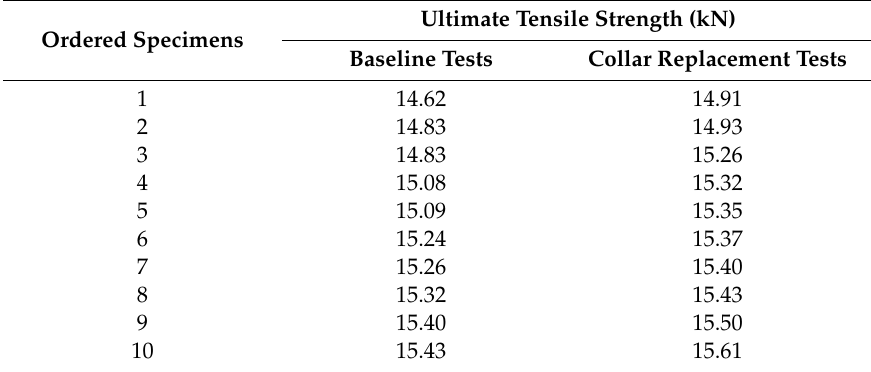
Table A2. Experimental data for static tensile strength—Figure 6.